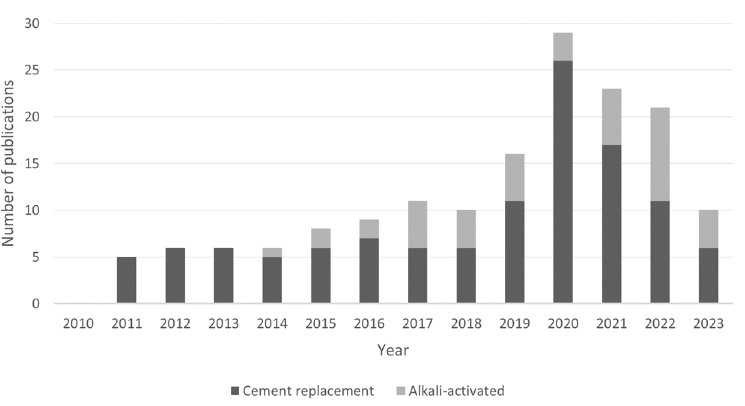
Figure 1. Number of publications listed in Scopus related to wood ash utilization in construction materials between 2010 and 2023 (accessed on 9 March 2023).